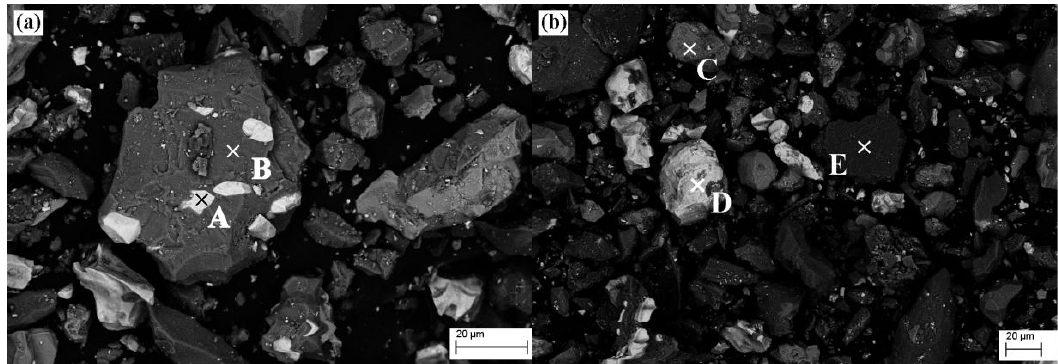
Figure 6. Scanning electron microscopy (SEM) images of the mineralogical phases in Bayan Obo tailings ( a and b ): (A) Monazite; (B) Fluorite; (C) Hematite; (D) Bastnaesite; (E) Dolomite.